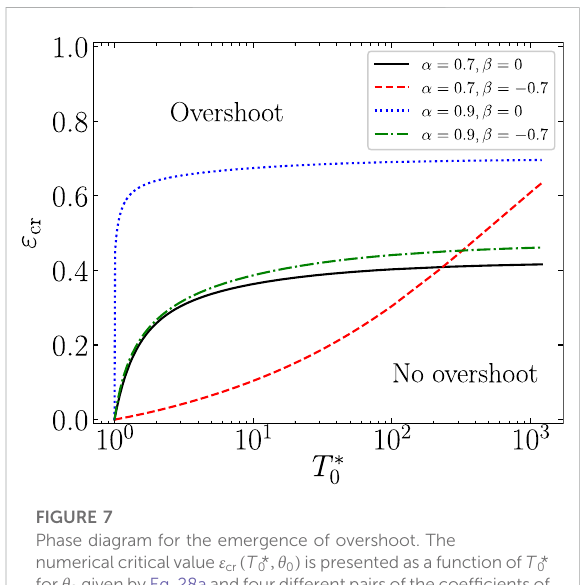
FIGURE 7 Phase diagram for the emergence of overshoot. The numerical critical value ε cr ( T 0 * , θ 0 ) is presented as a function of T 0 * for θ 0 givenbyEq.28aandfourdifferentpairsofthecoef fi cientsof restitution:( α , β )= (0.7, 0), (0.7, − 0.7), (0.9, 0), and (0.9, −